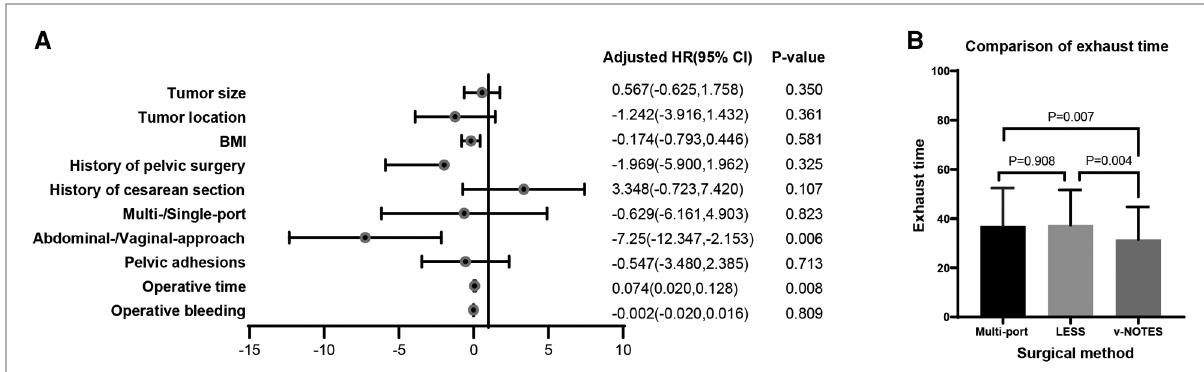
FIGURE 2 The impact of surgical characteristics on postoperative exhaust time. ( A ) Multivariable linear regression showed that postoperative exhaust time was positively associated with abdominal/vaginal approach type, with the postoperative exhaust time getting reduced by 7.25 h when the surgical approach is changed from transabdominal to transvaginal (beta-value: − 7.250, 95% CI, − 12.347 to − 2.153, p =0.006) and operative time (beta- value: 0.074, 95% CI, 0.020 – 0.128, p =0.008); ( B ) The postoperative exhaust time was signi fi cantly different between the myomectomy types (vNOTES group vs. LESS group, p =0.004; vNOTES group vs. multiport group, p